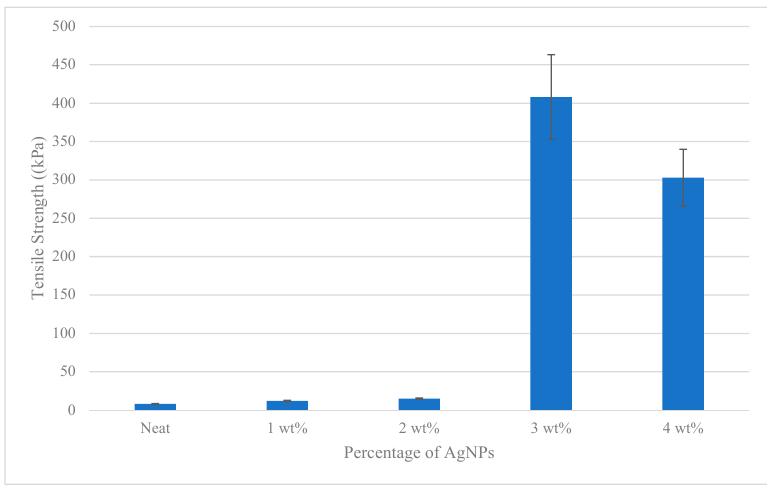
Figure 7. The strength of antibacterial films containing AgNPs nanometals.